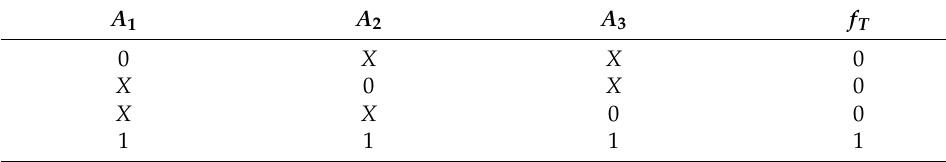
Table 13. Boolean relations for three